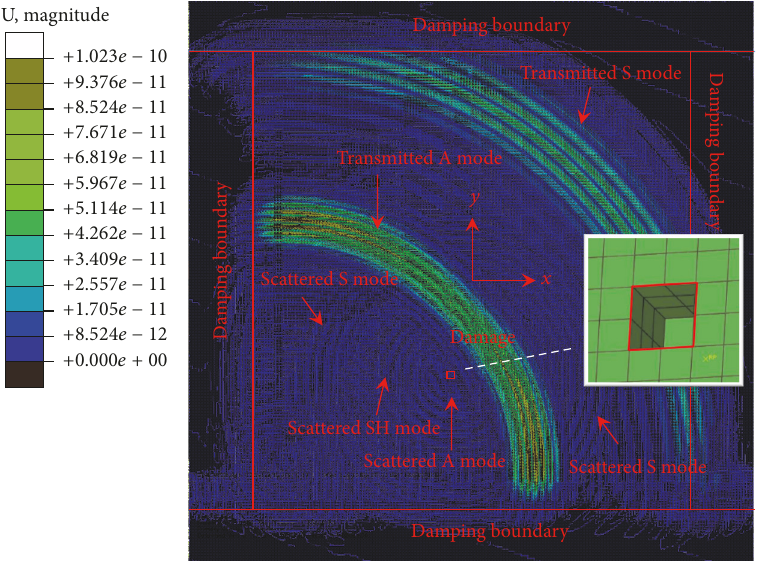
Figure 9: Wave scattering at